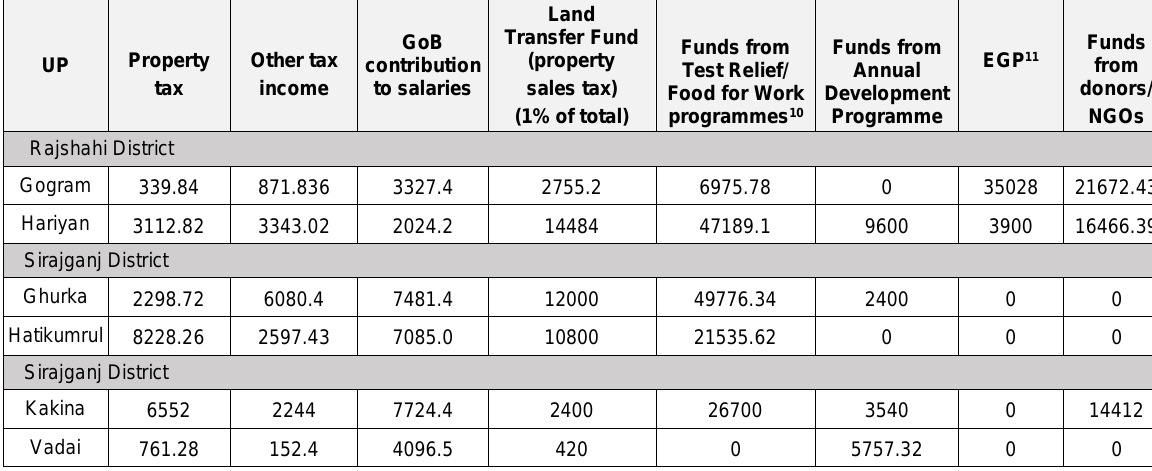
Table 5: Income sources of the six UPs under study (2011-12) (Amount in USD)